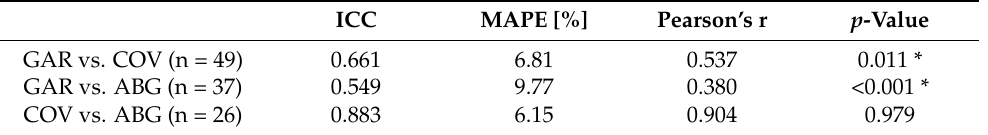
Table 2. Validity criteria of GAR-derived SO 2 values compared to those obtained with a medical device (COV) and with arterial blood gas analysis (ABG) at 4559 m.